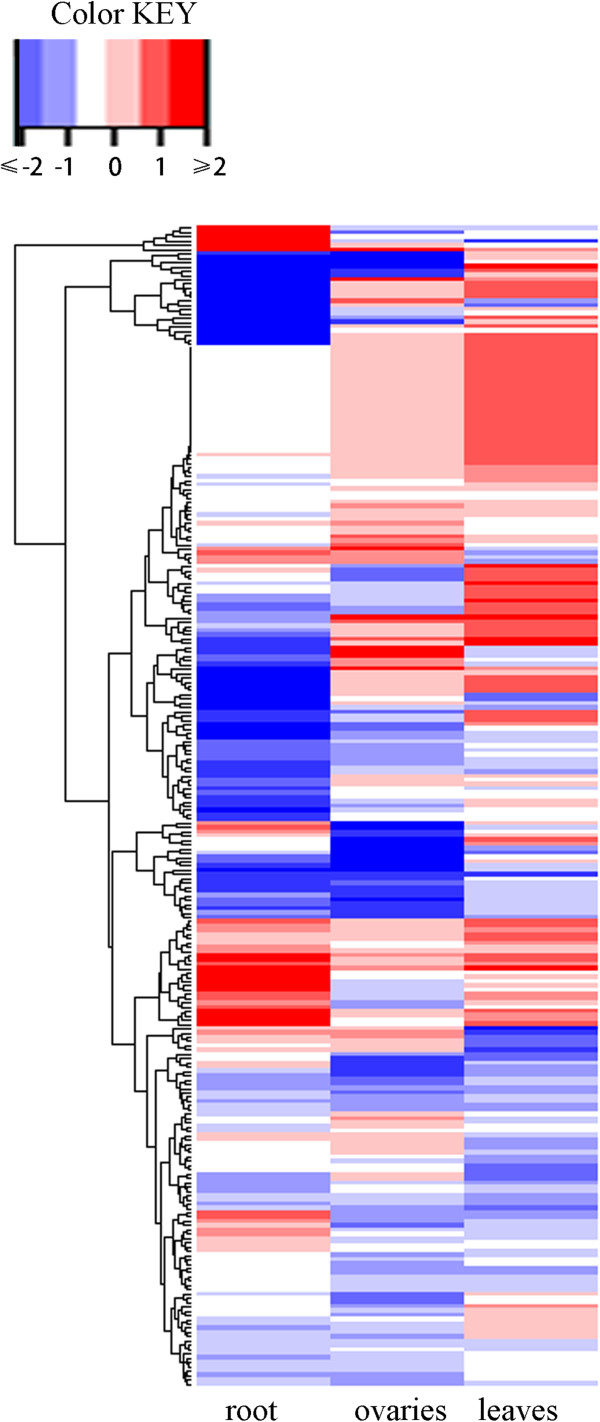
Clustering of candidate genes according to their changed expression levels in water-stress condition. The color scale shown on the top left represents the changed gene expression values (Log2 fold change) under water-stressed condition. “roots”, “ovaries” and “leaves” column present the tested genes in the roots, ovaries and the basal leaves, respectively. The dose red and blue colors represent up-and down-regulated expression, respectively.